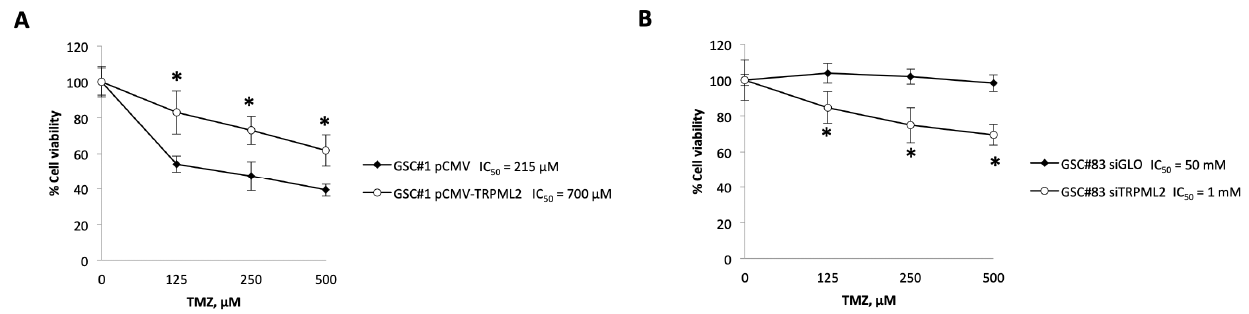
Figure 3. Effects of TMZ on growth of GSC#1 and GSC#83. Cell growth after 48 TMZ treatment was evaluated by MTT assay in ( A ) TRPML2 negative GSC#1 (pCMV) and in GSC#1 pCMV-TRPML2, and ( B ) TRPML2 positive GSC#83 (siGLO) and in GSC#83 siTRPML2. Data shown are expressed as mean ± SE of three separate experiments. * p < 0.05 vs. control cells (GSC#1 pCMV and GSC#83 siGLO).